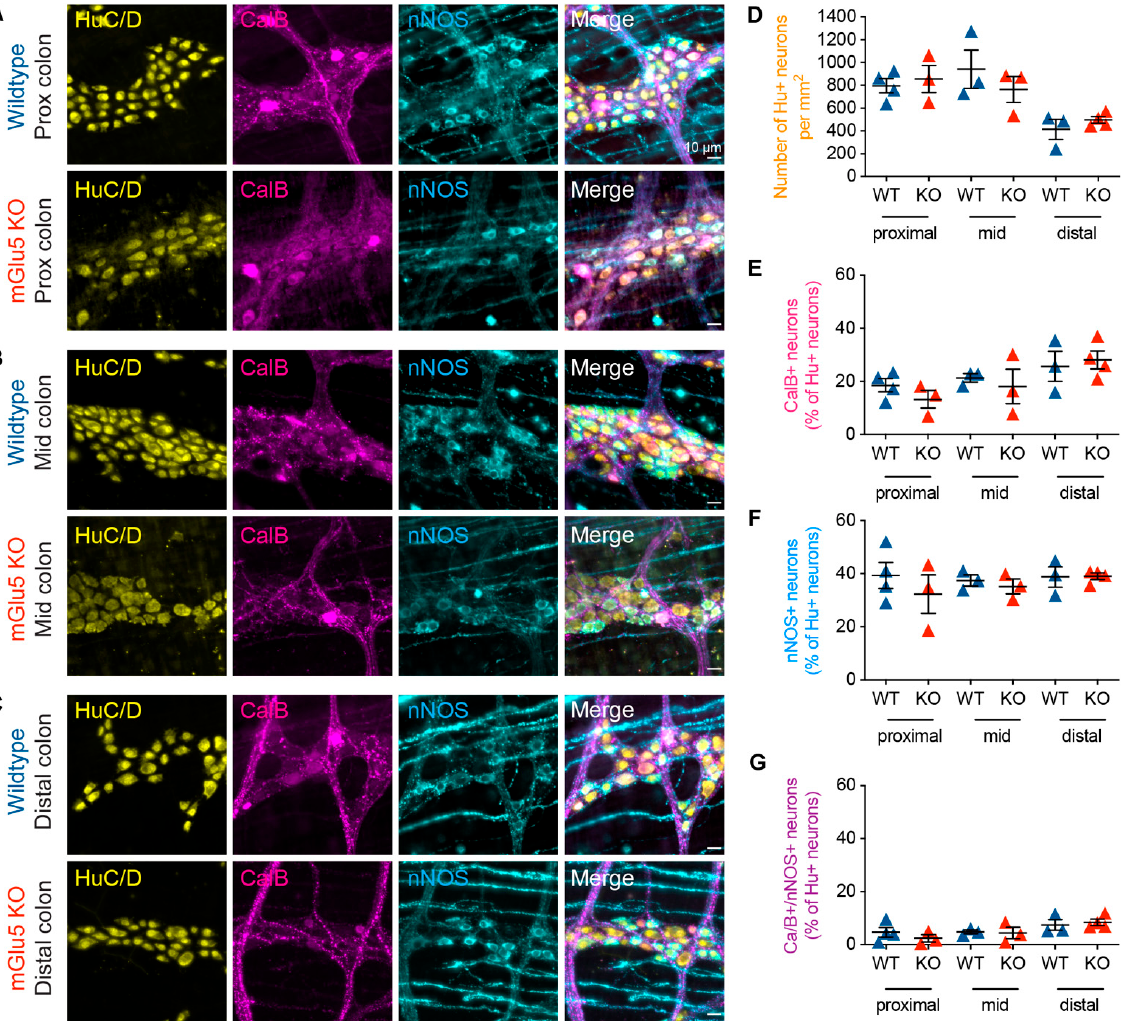
Figure 7. mGlu5 KO mice showed no alteration in proportions of myenteric neurochemical subtypes in the mouse colon. ( A – C ) Representative images of immunofluorescence staining of the myenteric plexus of the mouse colon, showing labeling of the pan-neuronal marker Hu (yellow), CalB (magenta), and nNOS (yellow) in wildtype and mGlu5 knock-out (KO) mice in the proximal, mid, and distal colon. ( D – G ) Cell count analysis revealed no significant difference in the density of Hu+ neurons (per mm 2 ), the proportion of CalB+ neurons (out of Hu+ neurons), the proportion of